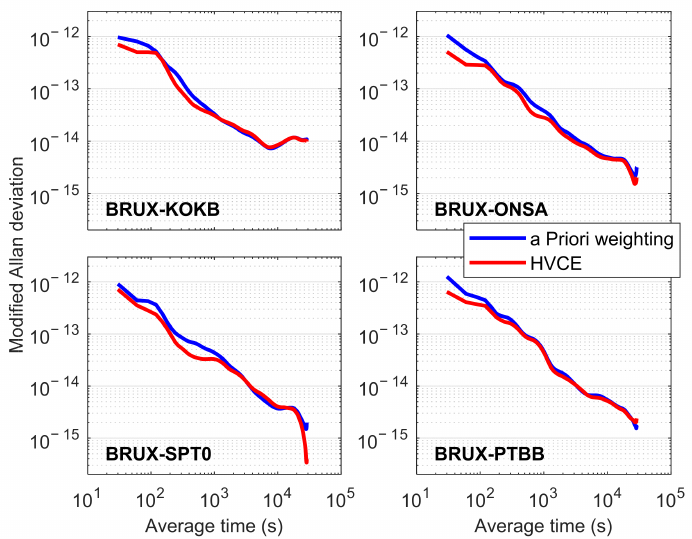
Figure 6. MDEV of four time links with the a priori weighting method and HVCE method on DOY 251,